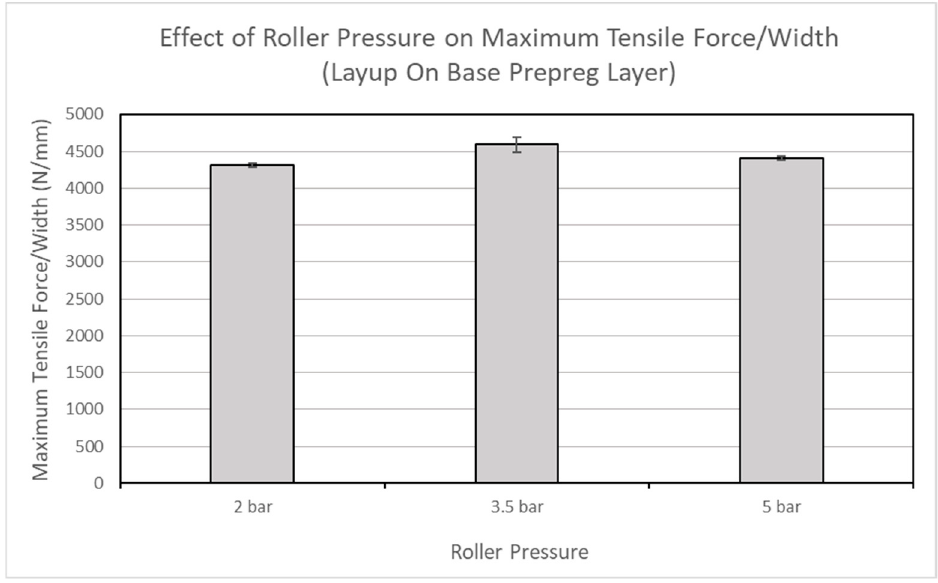
Figure 10. Effect of roller pressure and base layer on maximum tensile force/width for layups on prepreg base layer.